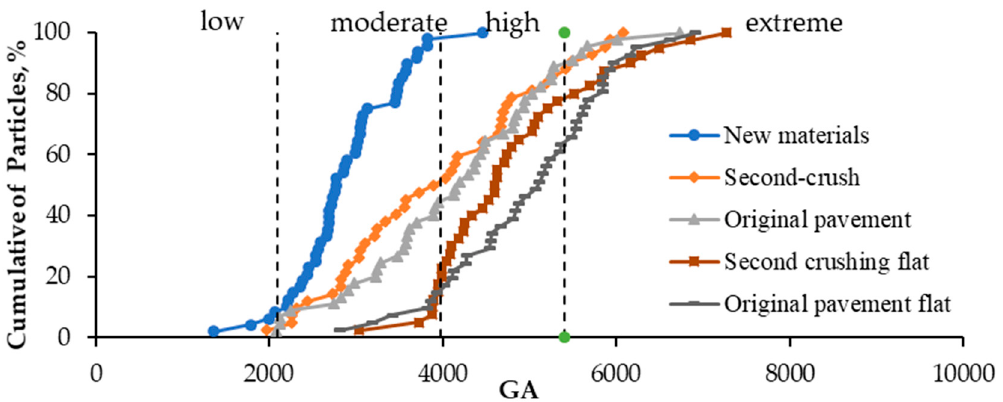
Figure 14. Comparison of edge angle between new and RAP materials.